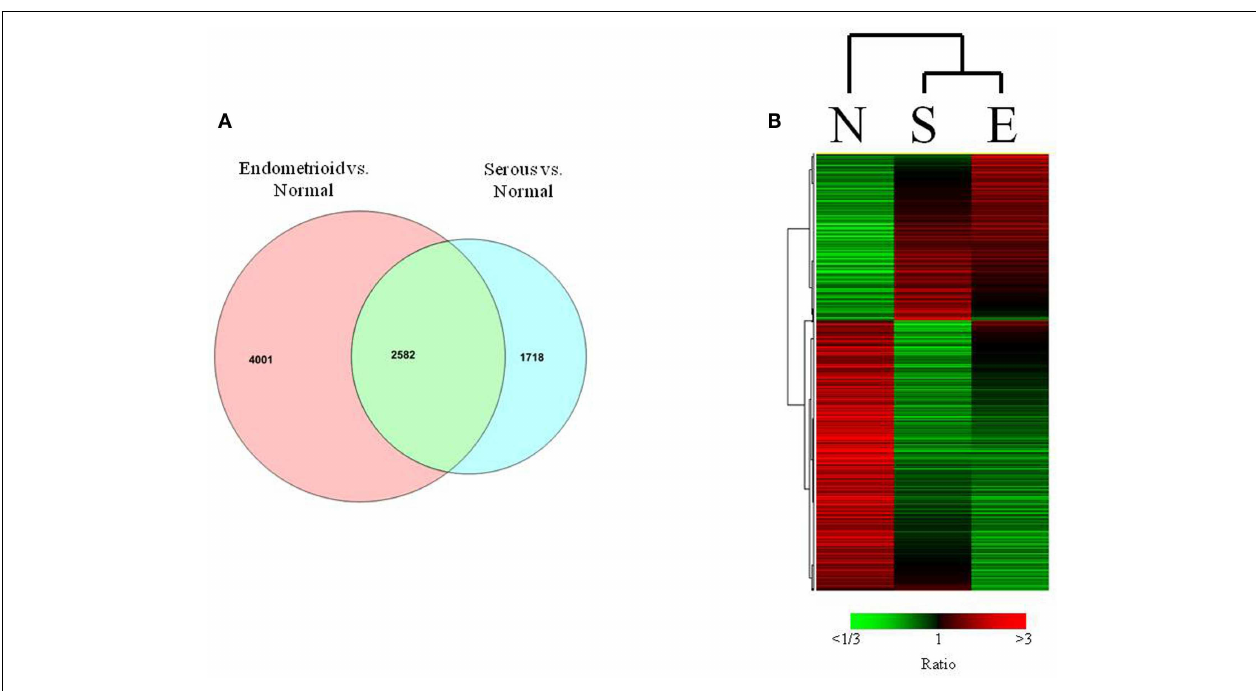
when compared to normal endometrium. (B) Heat map of differentially expressed transcripts in matched analysis of endometrioid, serous, and normal tissues.